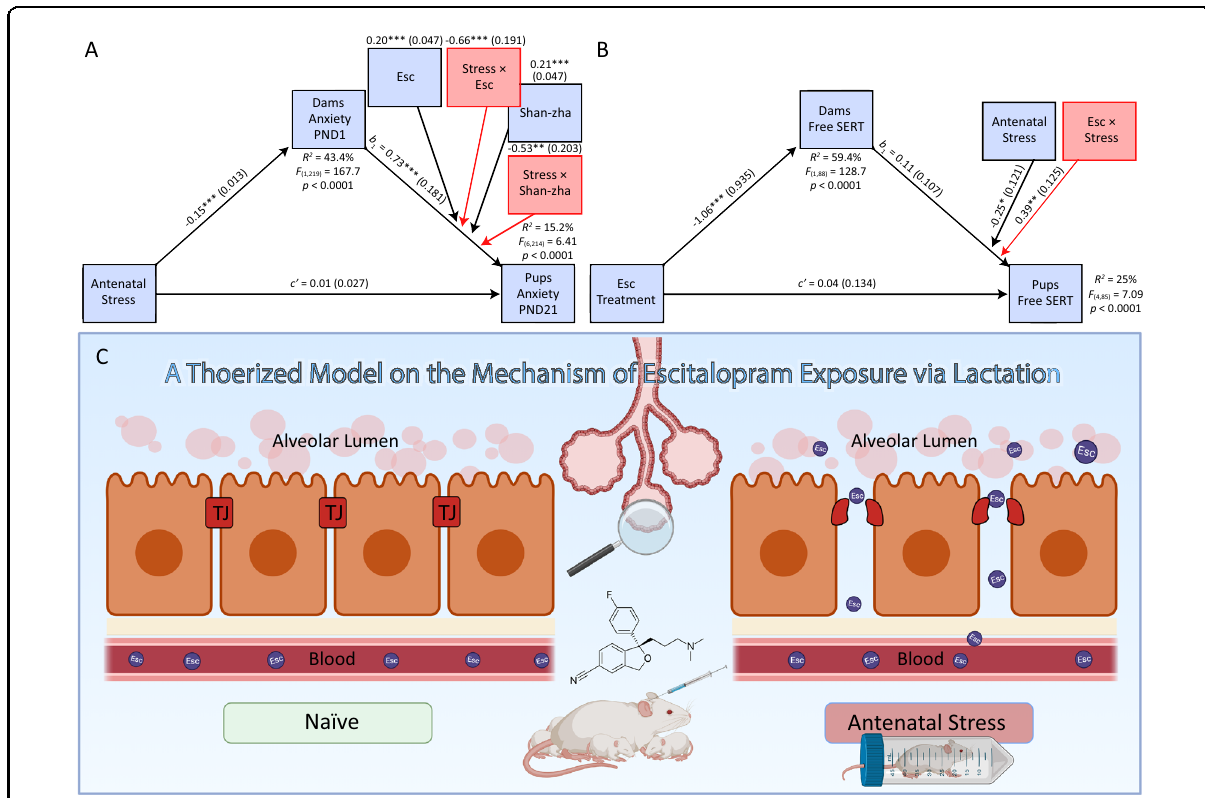
Fig. 4 Moderated mediation models. A Antenatal stress led to a signi fi cant decrease in the time dams spent in the open arms of the maze on PND 1 ( a 1 = − 0.15, p < 0.0001); chronic treatment with either escitalopram ( b 4 = − 0.66, p = 0.0007) or shan-zha ( b 5 = − 0.53, p = 0.009) to lactating dams that were exposed to antenatal stress signi fi cantly moderated the association between dams ’ and pups ’ anxiety. Higher values on the anxiety indices indicate diminished anxiety-like-behavior. N = 221. B Chronic treatment with escitalopram led to a signi fi cant decrease in dams ’ free SERT ( a 1 = − 1.06, p < 0.0001); exposure to antenatal stress served as a precursor for the association between dams ’ and pups ’ free SERT ( b suggesting that antenatal stress exacerbated the transfer of escitalopram from dams to pups via lactation. N = 90. C A graphical depiction of the hypothesized mechanism by which antenatal stress might exacerbate pups ’ exposure to escitalopram; putatively, via durable alterations of the permeability of the mammary glandular epithelium that is instigated in the critical stage of mid-to-late gestation. Created with BioRender.com. Esc escitalopram, TJ tight junction. * p < 0.05, ** p < 0.01, *** p <